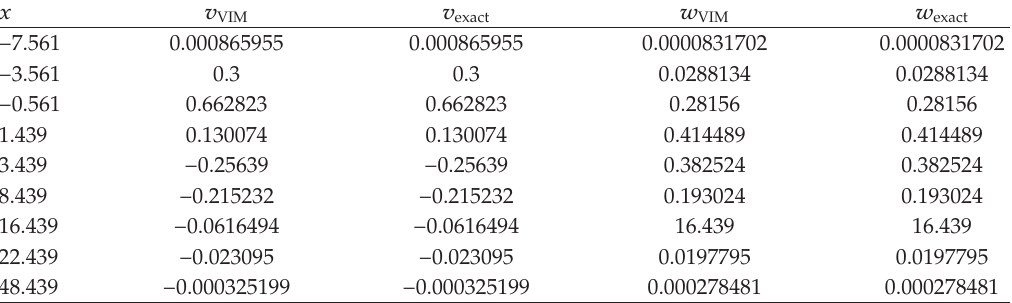
Table 1: Comparison between the exact and approximate (cid:2) VIM (cid:3) solutions for the FN equations at time T (cid:8)